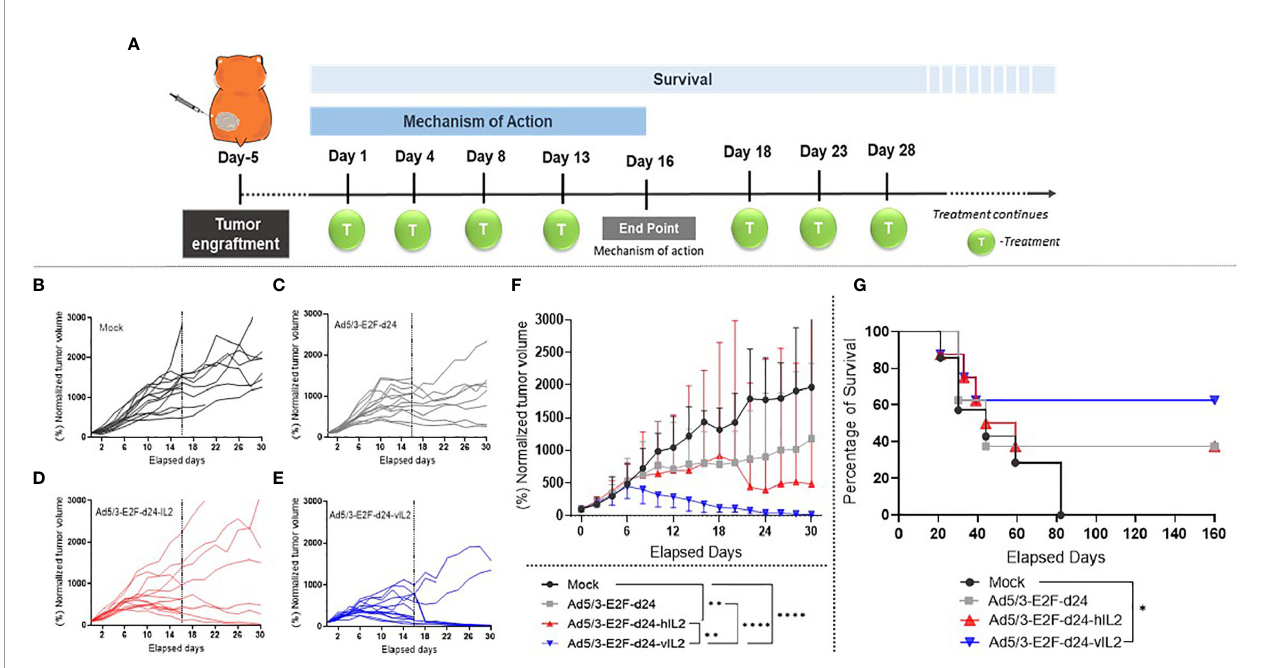
FIGURE 2 | Anti-tumor effects mediated by viral treatments in a hamster pre-clinical model. (A) Illustration of the experimental design. (B – E) Normalized individual tumor volumes from mechanism of action studies were plotted until the end of the experiment (dashed line on day 16), while the animals enrolled in the survival experiment continued being measured up to day 30. (F) Graphical representation of median tumor size, with bars showing range, until day 30. The tumor volume in percentage was obtained through the normalization of the daily tumor volumes to their respective day 0 tumor volume. (G) Survival curve of all experimental groups until day 160. *p < 0.05, **p < 0.01, and ****p <